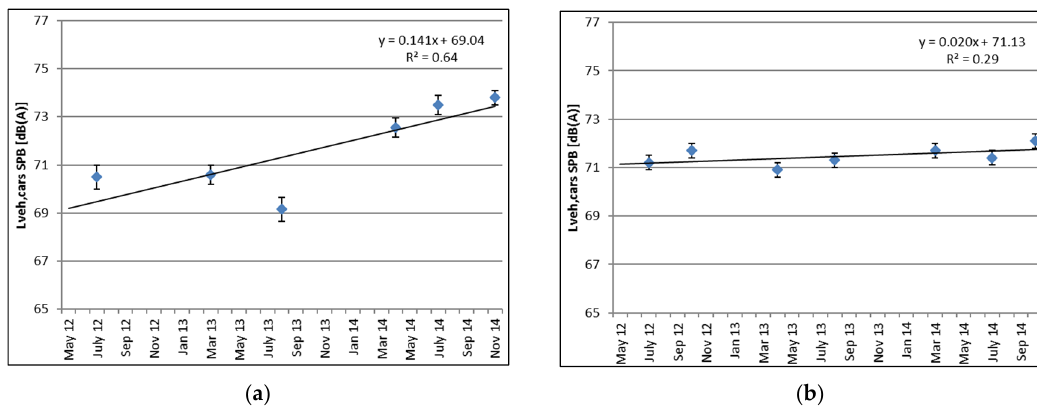
Figure 5. Increase over time based on SPB results for ( a ) Test Section 2 and ( b ) Test Section 6.